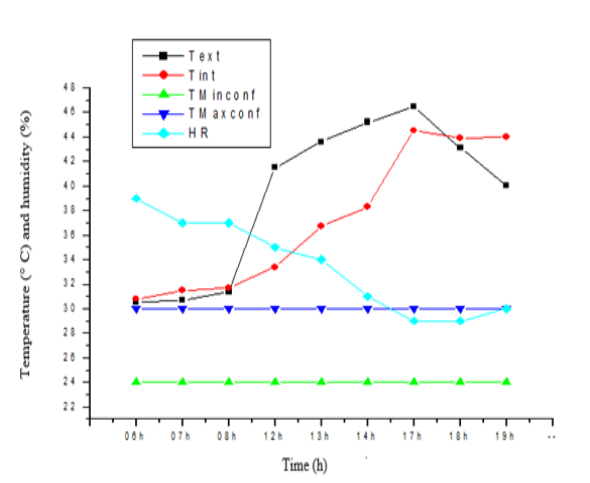
Figure 8. Change of the internal and external temperatures and humidity during the day